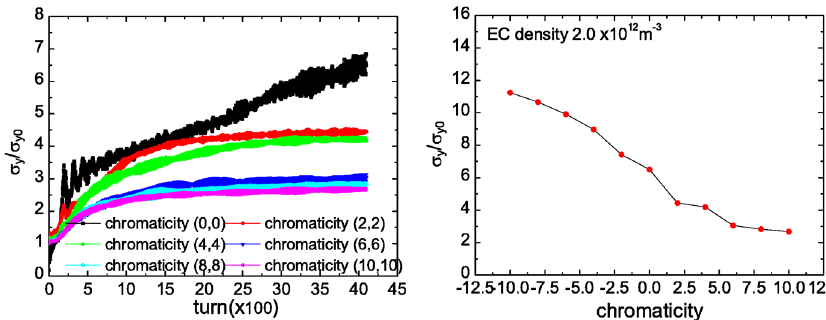
FIG. 17. (Color) The bunch size versus